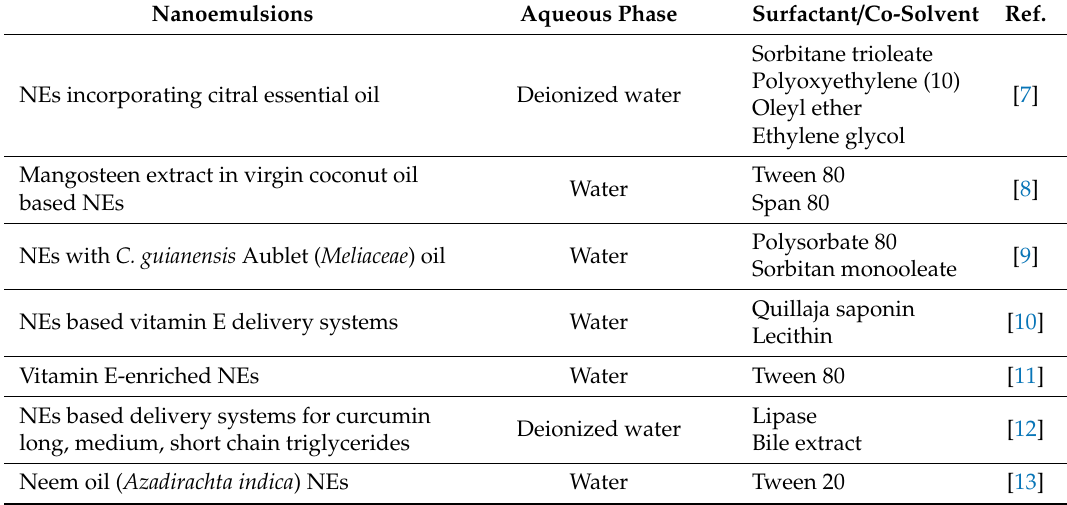
Table 1. Nanoemulsions (NEs) formulation using di ff erent oil phases, aqueous phases and surfactants. Nanoemulsions Aqueous Phase Surfactant / Co-Solvent